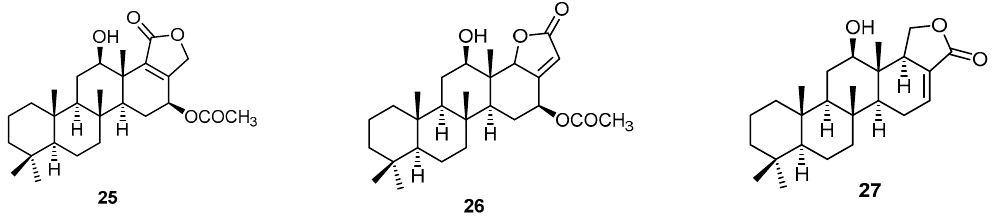
Figure 7. Chemical structures of sesterstatin 7 ( 25 ), 16- epi -scalarolbutenolide ( 26 ) and 25-dehydroxy- 12- epi -deacetylscalarin ( 27 ).